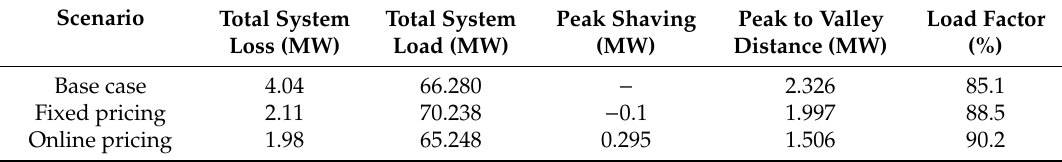
Table 11. Network operational